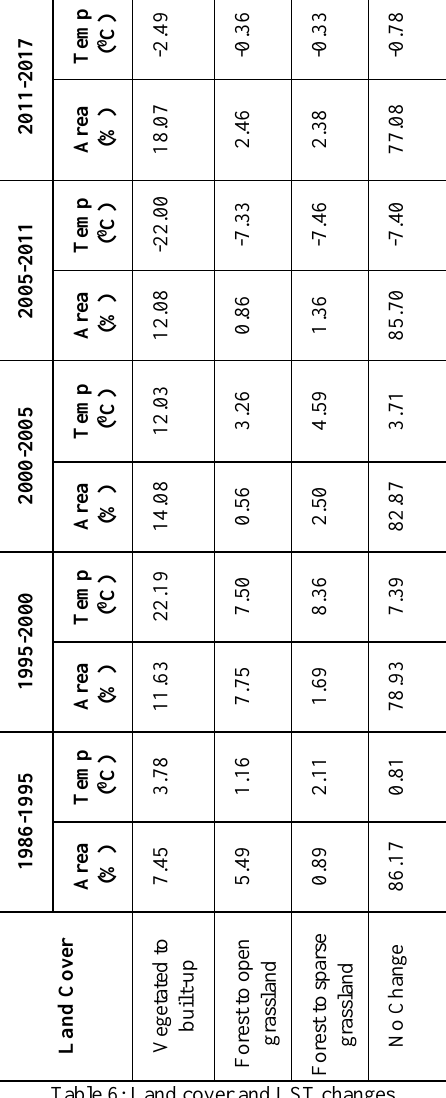
Table 6: Land cover and LST changes